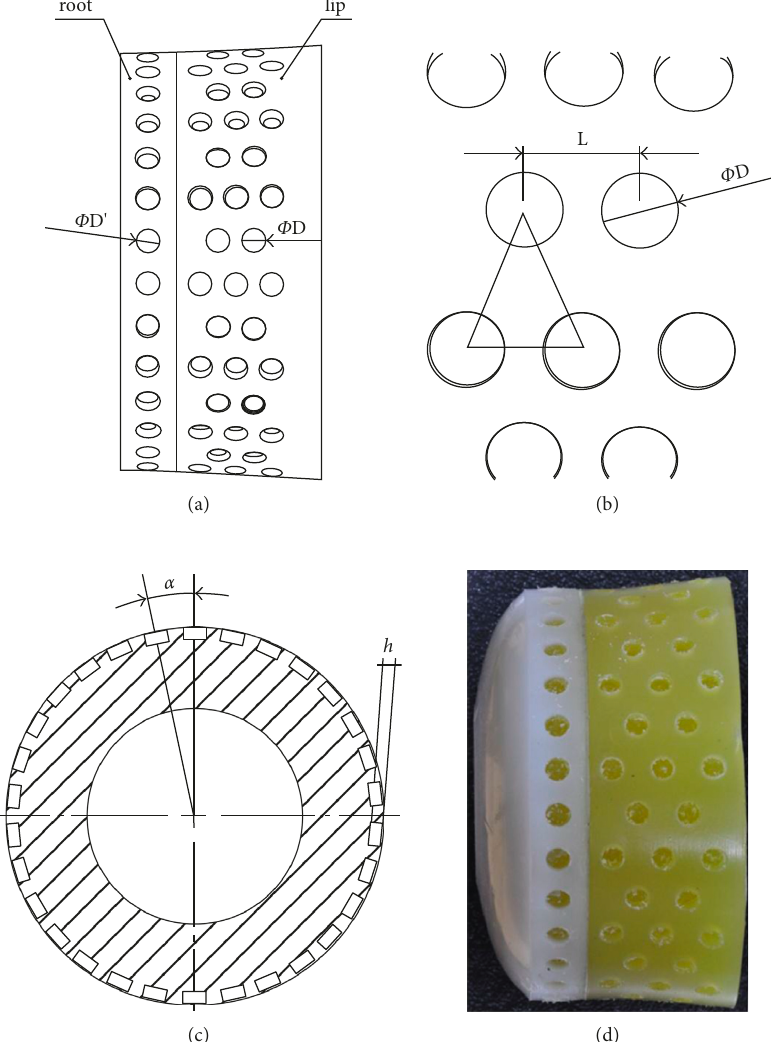
Figure 3: Schematic of dimpled piston: (a) dimpled layout of piston, (b) dimpled array form diagram, (c) cross section view of the piston leather cup, and (d) original picture of dimpled